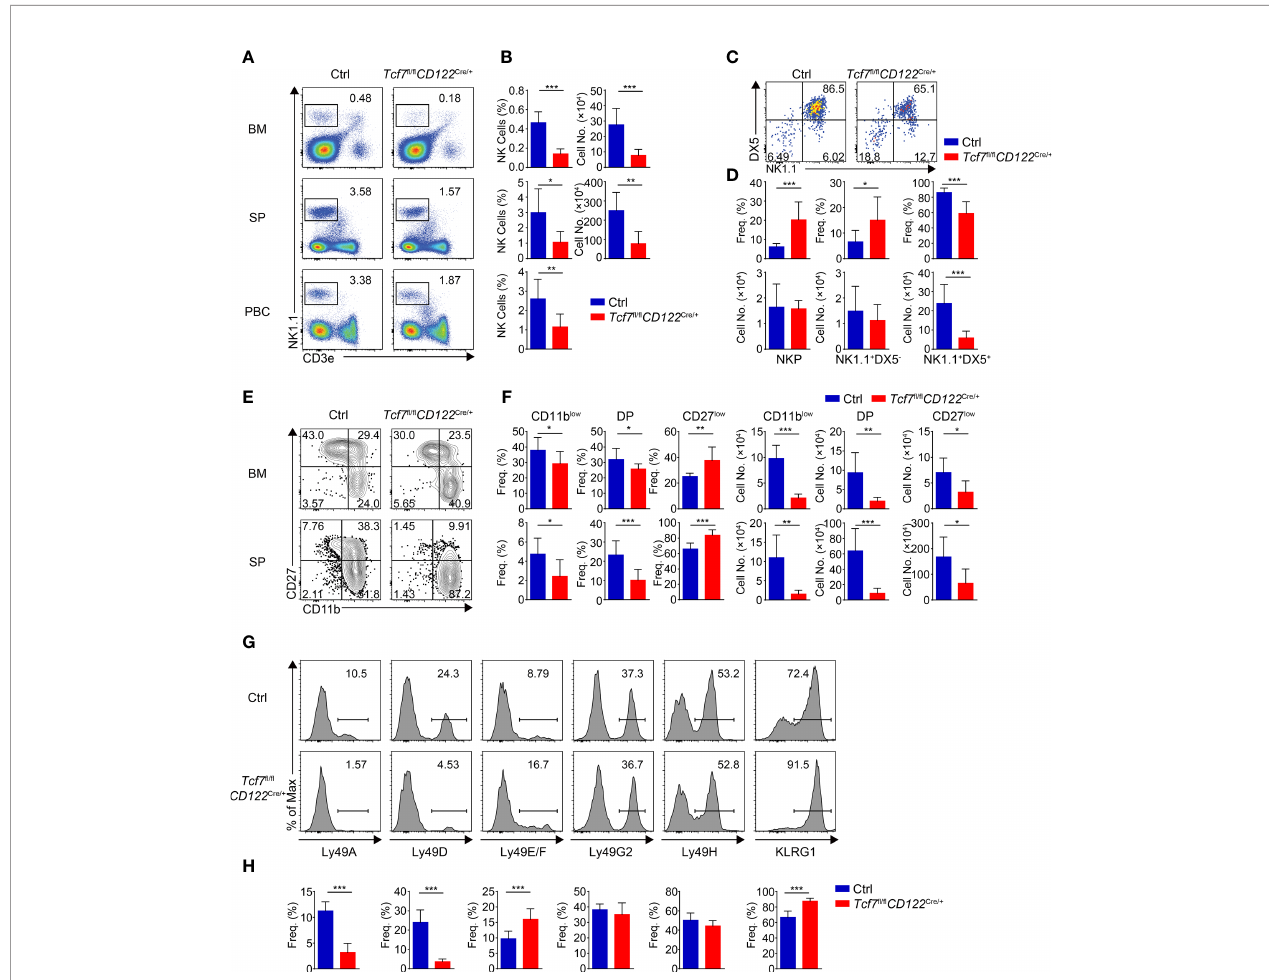
FIGURE 3 | Ablating Tcf1 at NKP stage results in severe defects in NK cell development. (A) Flow cytometry analysis of BM, SP, and PBCs from Ctrl and Tcf7 fl / fl CD122 Cre/+ mice. Representative pseudocolor plots showed total NK (CD3e − NK1.1 + ) cells from indicated tissue. (B) The frequency (left) and absolute numbers (right) of the NK cells from panel (A) are shown, accordingly (n ≥ 5 for each group). (C) Flow cytometry analysis of NKP cells in BM from Ctrl and Tcf7 fl / fl CD122 Cre/+ mice. The CD3e − CD122 + cells were further analyzed by using NK1.1 and DX5 staining. Representative pseudocolor plots showed NKP (DX5 − NK1.1 − ), DX5 − NK1.1 + , and DX5 + NK1.1 + cells. (D) The percentages (upper) and absolute numbers (lower) of NKP, DX5 − NK1.1 + , and DX5 + NK1.1 + cells from panel (C) are shown, accordingly (n ≥ 6 for each group). (E) Flow cytometry analysis of CD3e − NK1.1 + cell subsets from Ctrl and Tcf7 fl / fl CD122 Cre/+ mice. The CD3e − NK1.1 + cells from BM or SP were further analyzed by using CD11b and CD27 staining. Representative contour plots showed CD11b low (CD11b − CD27 + ), DP (CD11b + CD27 + ), and CD27 low (CD11b + CD27 − ) NK cells. (F) The frequency (left) and absolute numbers (right) of CD11b low , DP and CD27 low NK cells from panel (E) are shown, accordingly (n ≥ 5 for each group). (G, H) Representative histograms (G) showed the expression of Ly49A, Ly49D, Ly49E/F, Ly49G2, Ly49H, and KLRG1 in SP NK cells from Ctrl and Tcf7 fl / fl CD122 Cre/+ mice. The percentage of each receptor is shown in panel (H) , accordingly (n ≥ 6 for each group). All data represent at least three independent experiments. Statistical signi fi cance was determined by one-tailed Student ’ s t-test. * P < 0.05, ** P < 0.01, and *** P < 0.001. Data are means ±